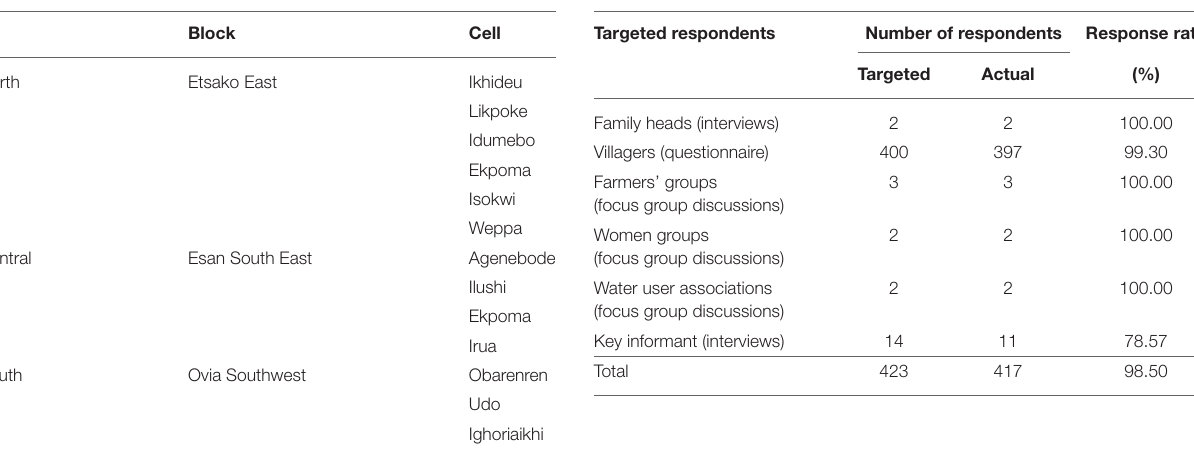
TABLE 2 | Distribution of the respondents used for the